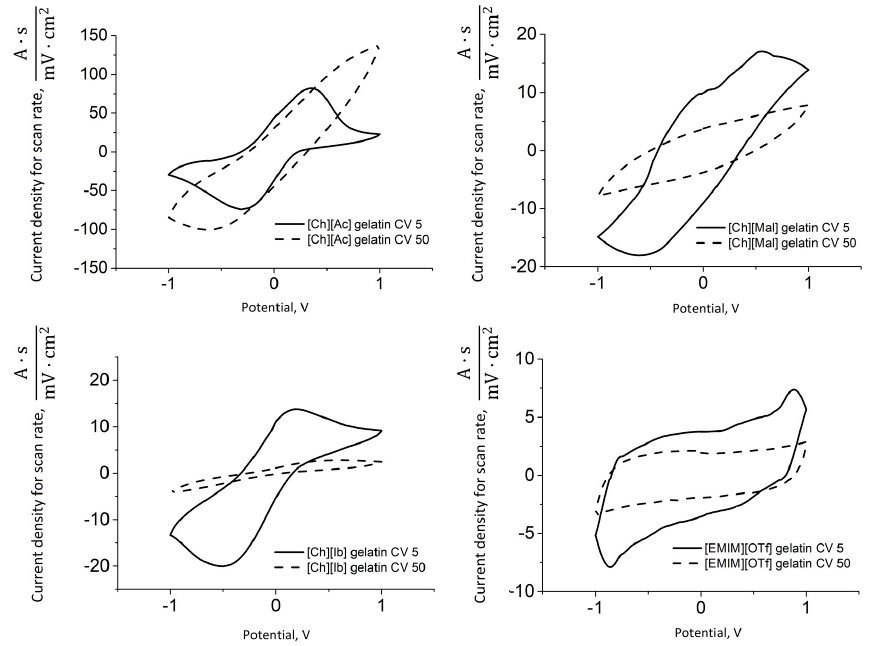
Figure 2. Cyclic voltammetry results for PPy-gelatin actuators. Solid lines for scan rates of 5 mV · s − 1 ; dashed lines for 50 mV · s − 1 .